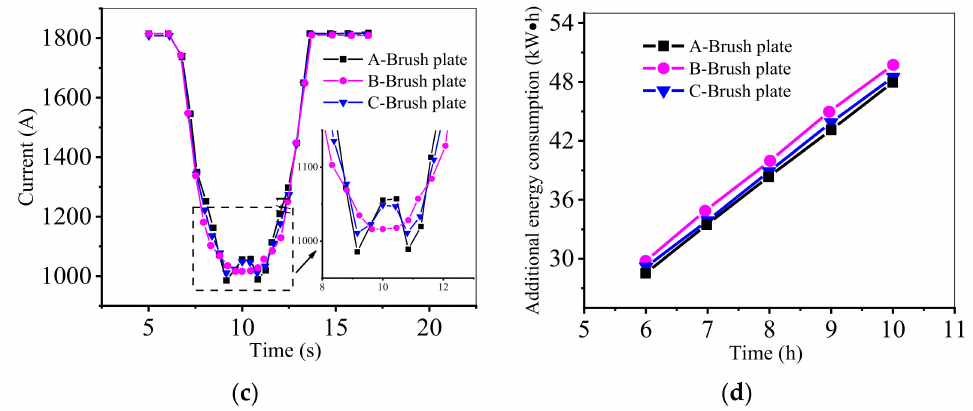
Figure 11. The variation of parameters with time. ( a ) The dimensionless current density; ( b ) Bath voltage; ( c ) Current; ( d ) Additional energy